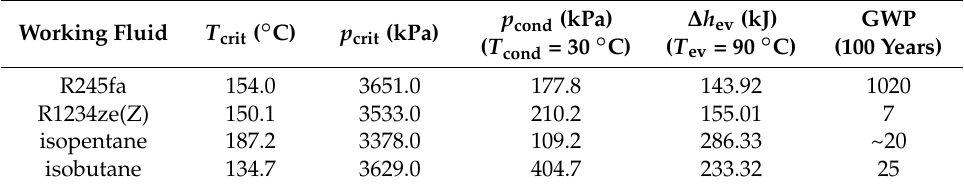
Table 2. Thermal properties of selected working